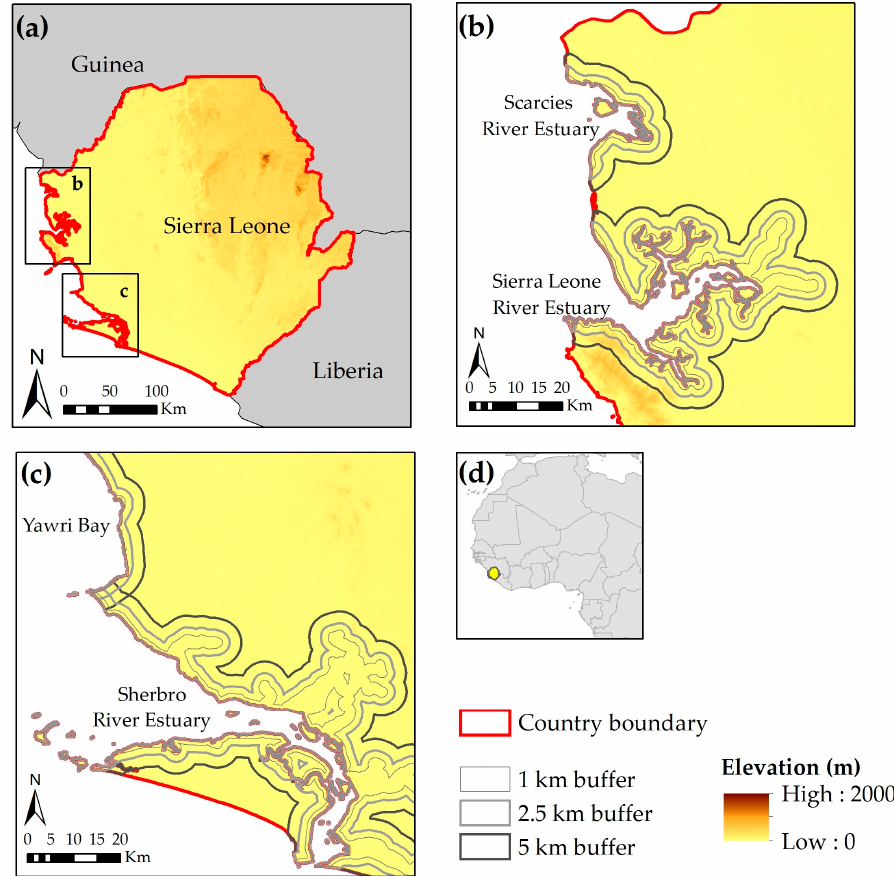
Figure 1. Location of the study area showing: ( a ) Regional topography with focus areas in northern Sierra Leone and Southern Sierra Leone defined by rectangles; ( b ) Focus areas in northern Sierra Leone (Scarcies River Estuary and Sierra Leone River Estuary) with multiple buffers extending inland from the estuary boundary; ( c ) Focus areas in southern Sierra Leone (Yawri Bay and Sherbro River Estuary) with multiple buffers extending inland from the estuary boundary; ( d ) Location of Sierra Leone in West Africa.